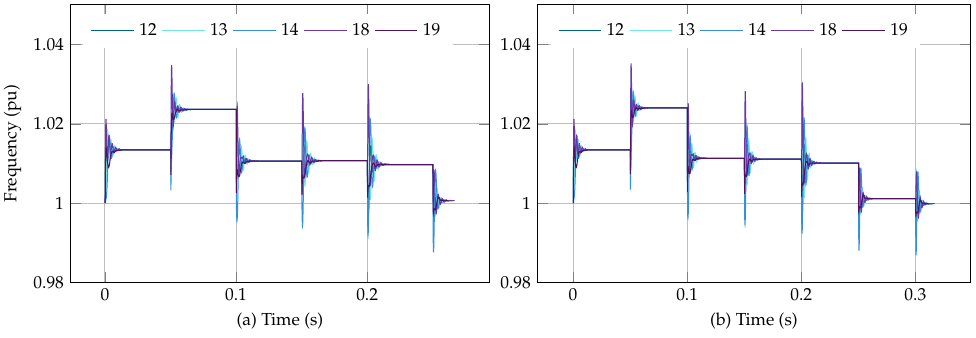
0 0.1 Figure 8. Frequency dynamics at each converter for load case 2. ( a ) Constant load model. ( b ) Frequency-dependent load